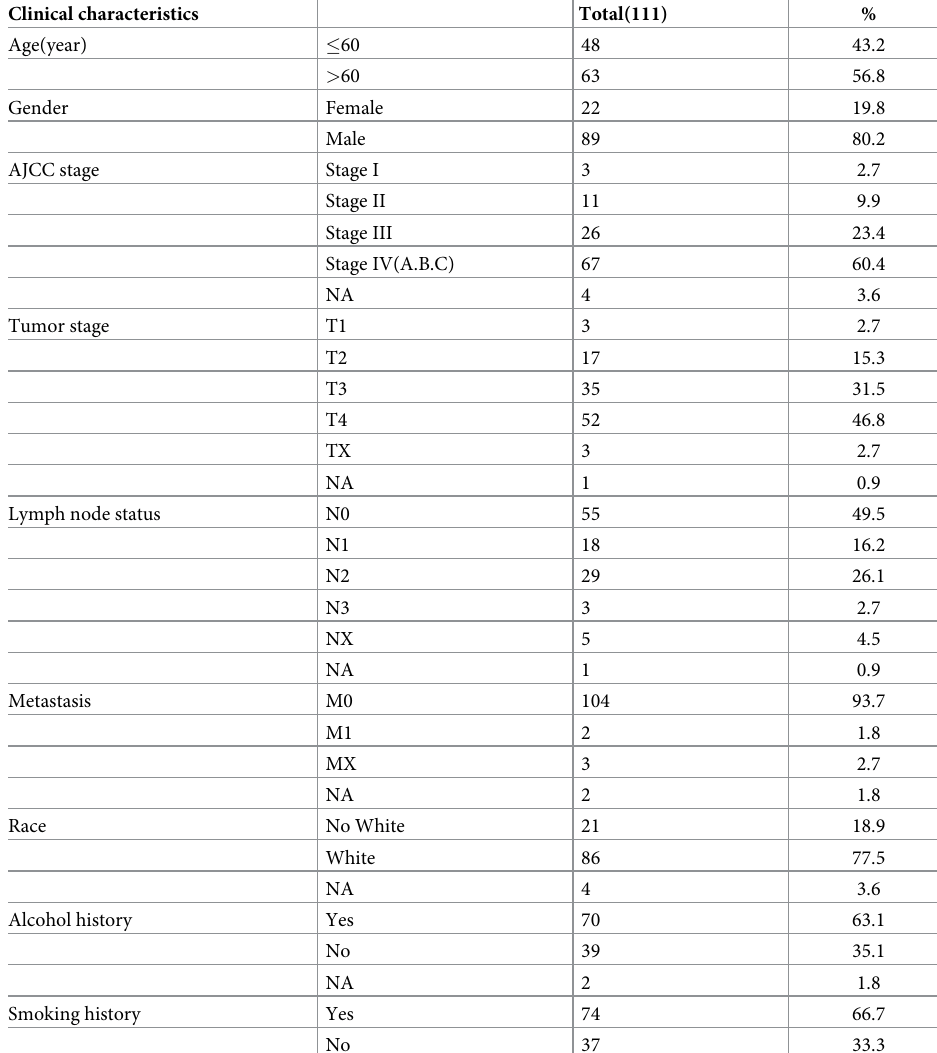
Table 1. TCGA laryngeal cancer patient characteristics. Clinical